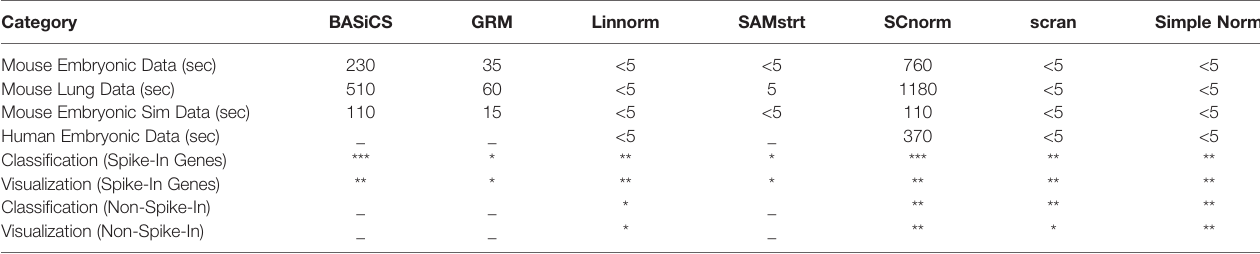
TABLE 5 | Comparison of normalization methods used, including execution time (rounded to nearest fi ve seconds), visualization, and classi fi cation rate across all data sets. Category BASiCS